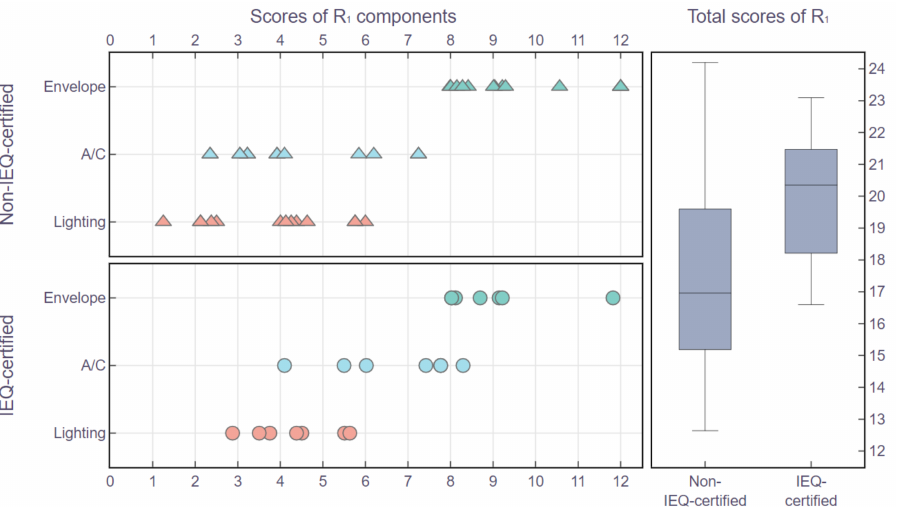
Figure 2. Scores of the total and three aspects of the energy conservation category. Green represents Envelope, blue represents A/C, orange represents Lighting. And the triangle represents non-IEQ- certified, the circular represents IEQ-certified.